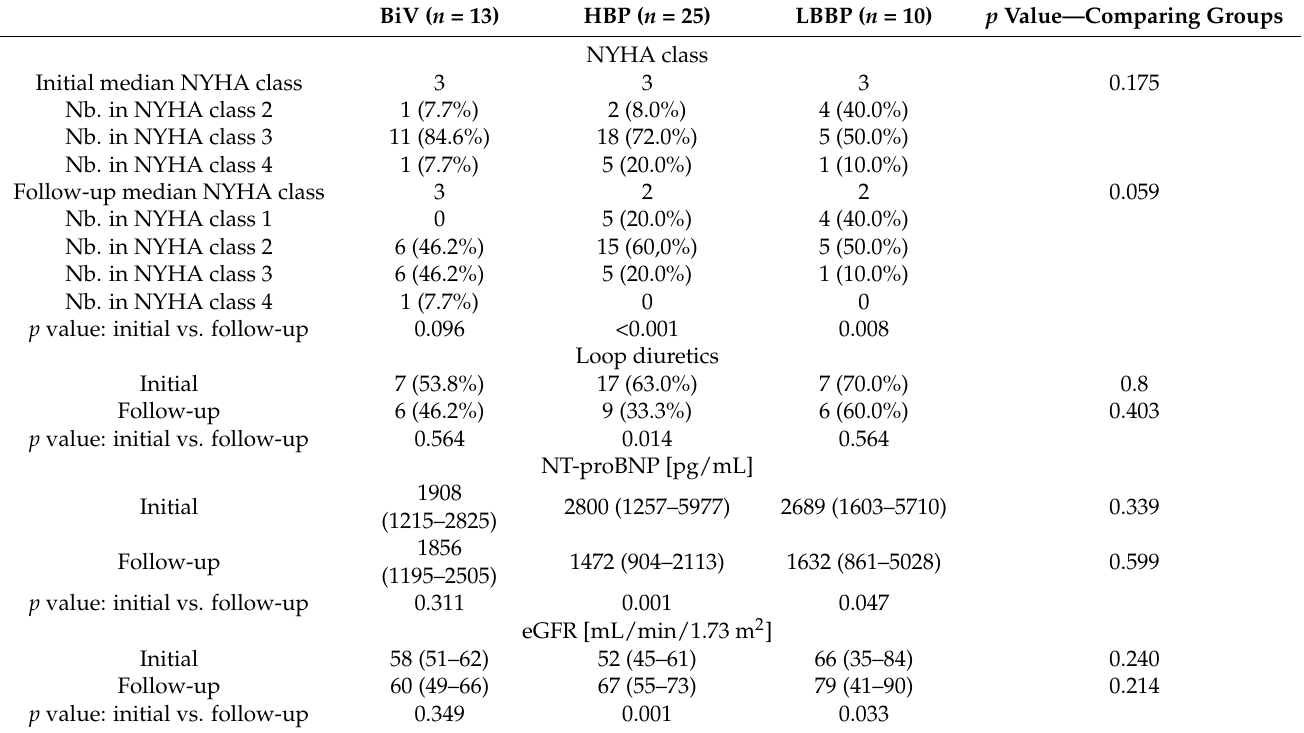
Table 4. Clinical and laboratory features of patients by pacing modality at baseline and